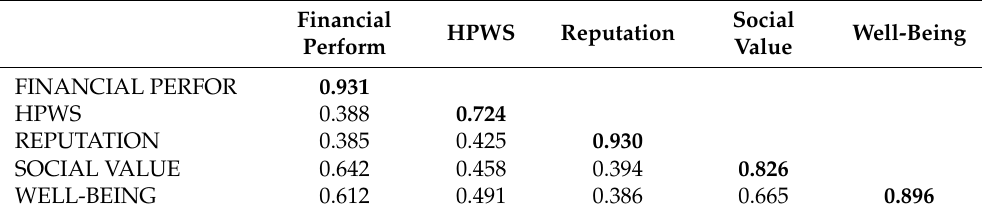
Table 2. Fornell–Larcker Criterion. (Source: our own based on SmartPLS).